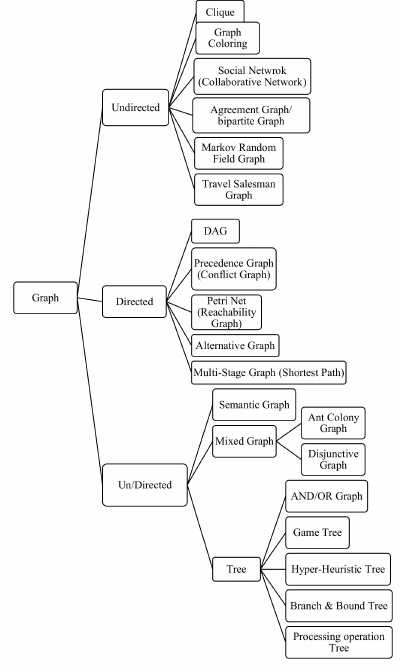
Figure 8. Categorization of different types of graphs.